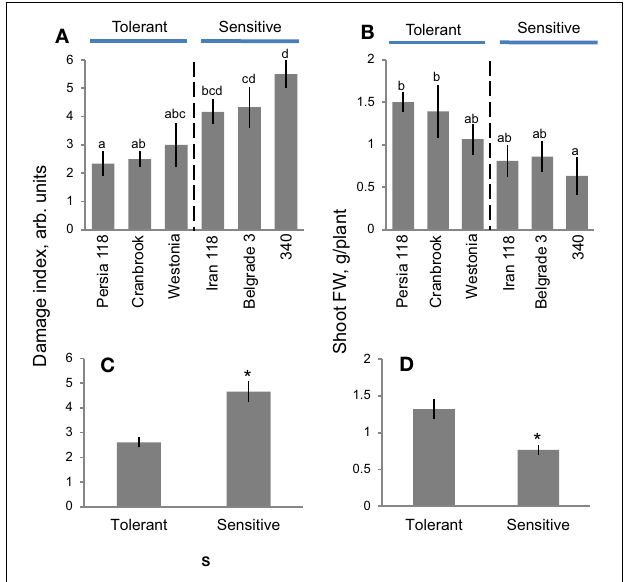
FIGURE 3 | Genetic variability of salinity stress tolerance in bread wheat. Damage index (A) and shoot fresh weight (B) of six bread wheat cultivars contrasting in their salinity tolerance after 38 days of 300mM NaCl treatment in a glasshouse. Different lowercase letters represent significant differences between varieties at P < 0 . 05. (C,D) Average pooled data for tolerant and sensitive clusters shown in A,B . Mean ± SE ( n = 3; 24 plants in total, eight plants in each pots). Asterisk indicates significant difference between clusters at P < 0 . 05.